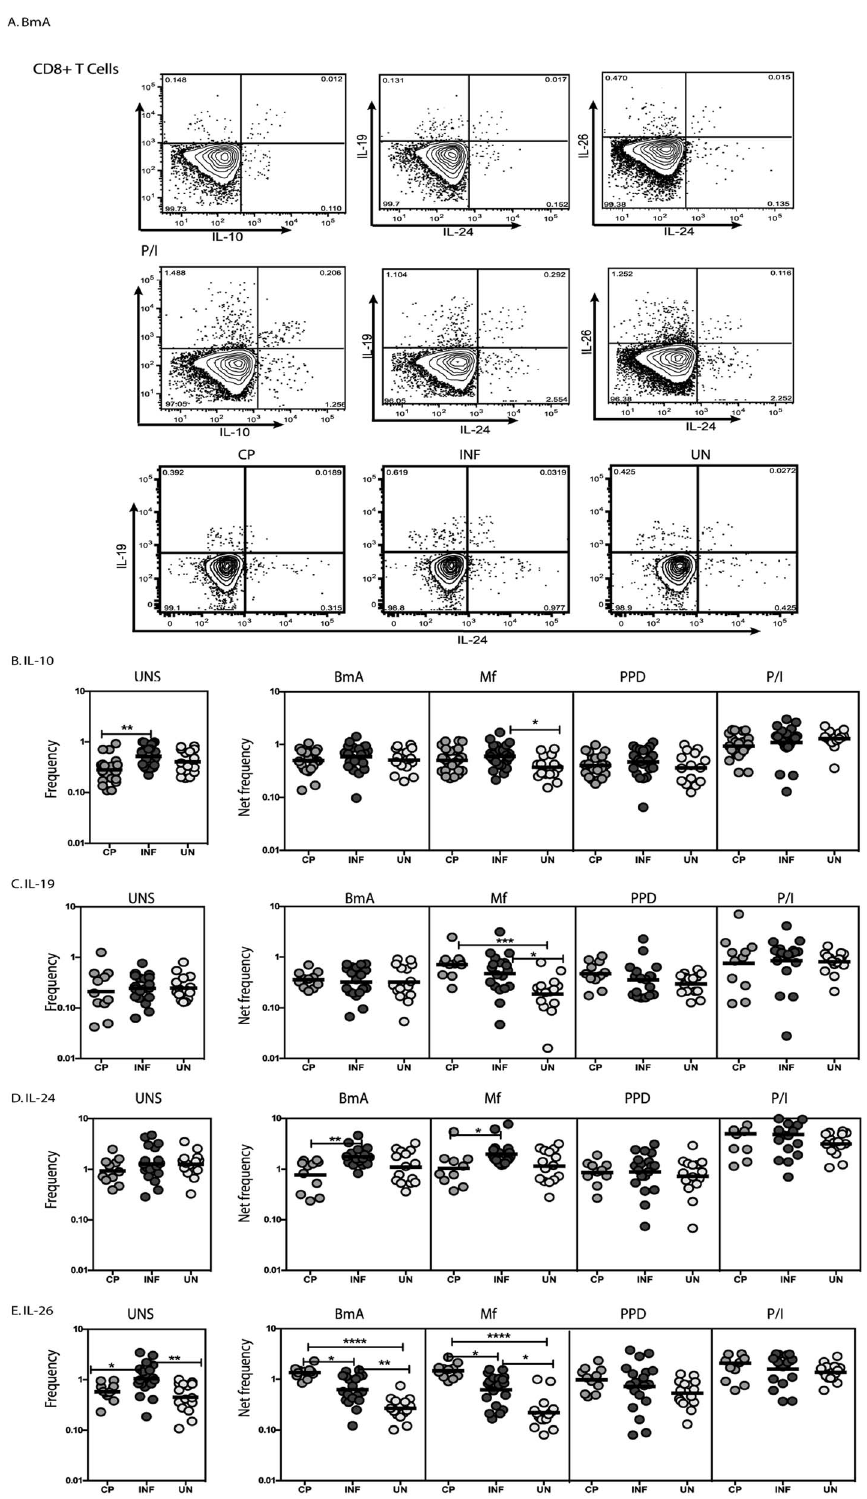
Figure 2. Filarial infection is associated with increased frequencies of IL-24 expressing and decreased frequencies of IL-26 expressing CD8 + T cells. (A) A representative dot plot from a filarial - infected individual showing CD8 + T cell expression of IL-10, IL-19, IL-24 and IL- 26 in response to BmA and PMA/Ionomycin and representative dot plots from CP, INF and UN individuals for CD4 + T cell expression of IL-19 and IL-24. The frequencies of CD8 + T cells expressing IL-10 (B), IL-19 (C), IL-24 (D) and IL-26 (E) at baseline and following stimulation with BmA, Mf, PPD and PMA/ionomycin in CP (n=23), INF (n=25) and UN (n=15) individuals. Antigen – stimulated frequencies are shown as net frequencies with the baseline levels subtracted. The data are shown as scatter plots with each circle representing a single individual. P values were calculated using the Kruskal-Wallis test with Dunn’s multiple comparisons (* p , 0.05, ** p , 0.01, *** p , 0.001). doi:10.1371/journal.pntd.0002762.g002 PLOS Neglected Tropical Diseases |